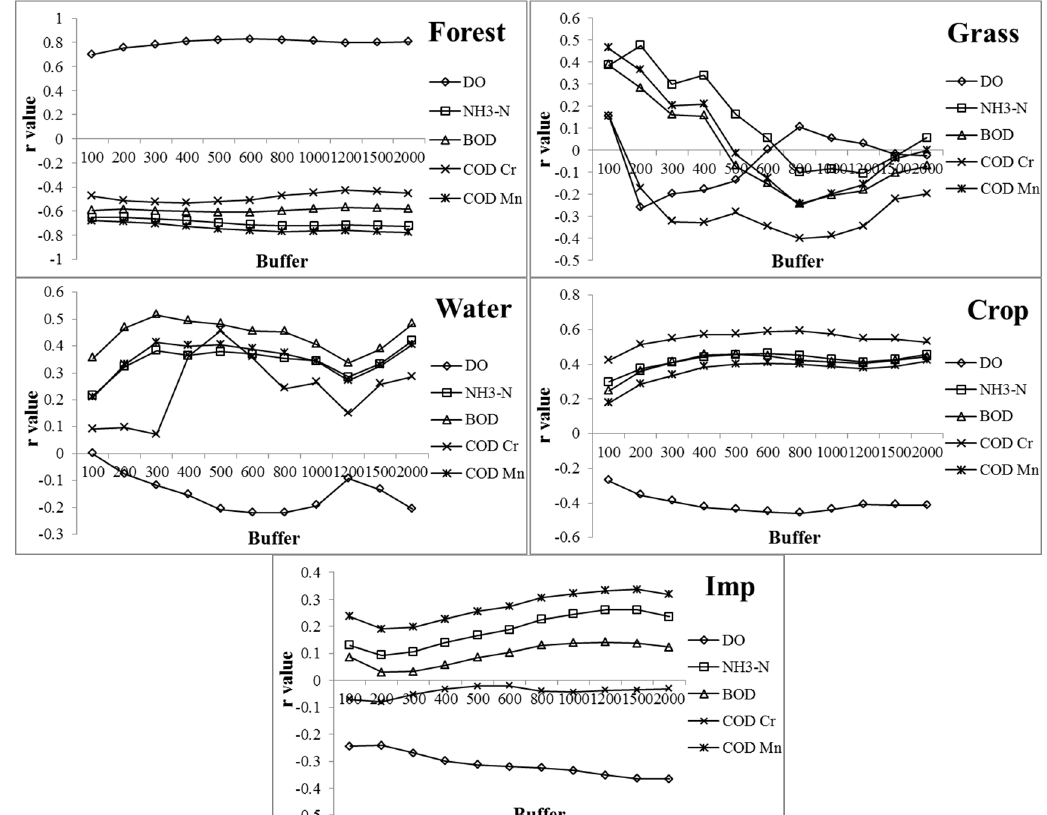
Figure 6. Pearson relationships between the LULC types of Forest, Grass, Water, Crop, and Imp (impervious surface) and water quality variables within the buffer of 100–2000 m.